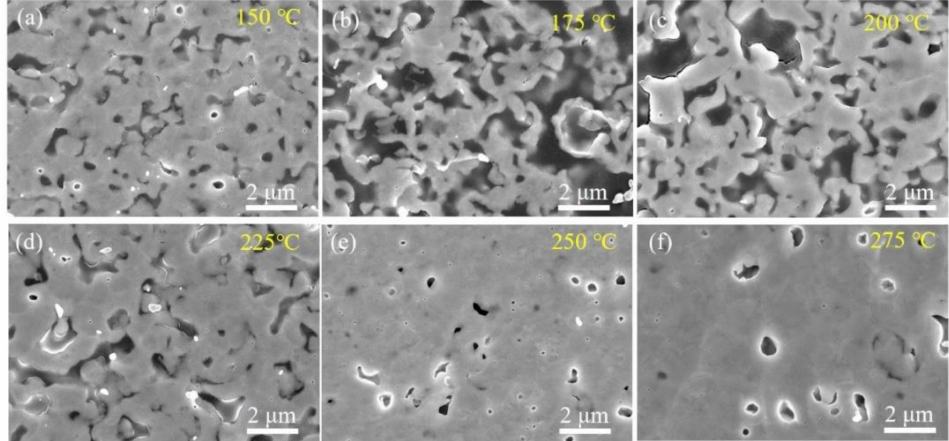
Figure 8. SEM images of cross-sectional structures of specimens sintered at the following different temperatures for 30 min: ( a ) 150 ◦ C, ( b ) 175 ◦ C, ( c ) 200 ◦ C, ( d ) 225 ◦ C, ( e ) 250 ◦ C and ( f ) 275 ◦